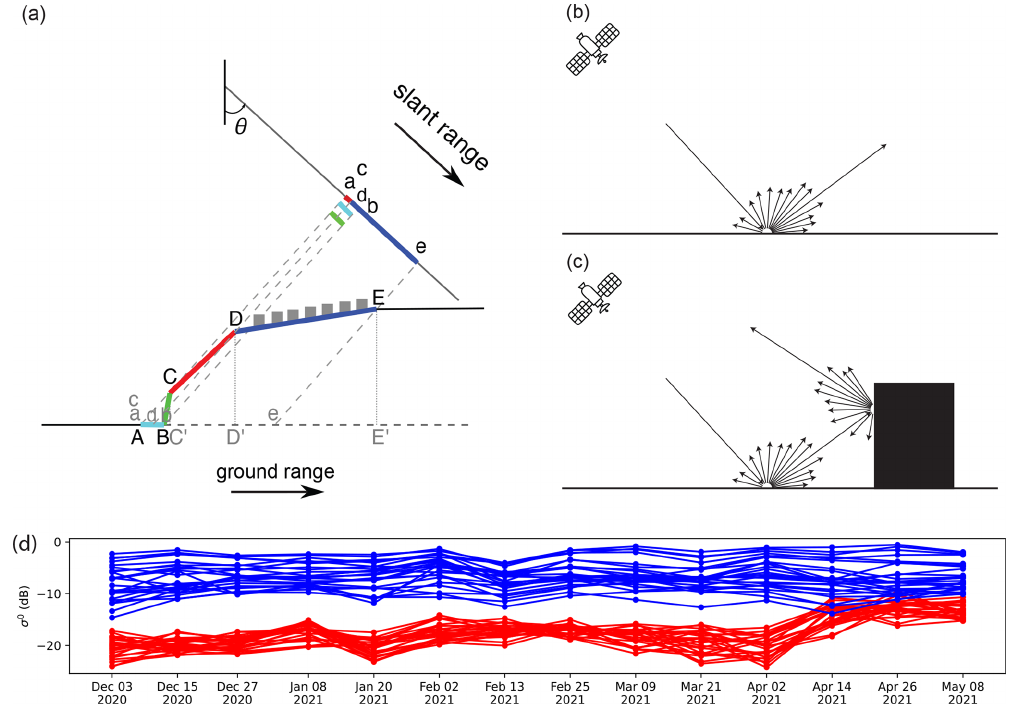
Figure 2. (a) Simplified scheme of the elevation profile at the line AE in Fig. 1c, inset (ii). (b) Diagram of the radar pulse, I a , backscattered from the ground. (c) Diagram of the radar pulses backscattered from the ground, I a , and the makeshift shelter, I b . (d) Red lines: SAR backscattering intensity time series at some representative points of the recently invaded land in the Morro Solar. The sudden increment from 14 April denotes the change in the backscatter mechanism from the mechanism shown in (b) to that shown in (c) . Blue lines: SAR backscattering intensity time series at some points of an old informal settlement located close to the recently invaded land.